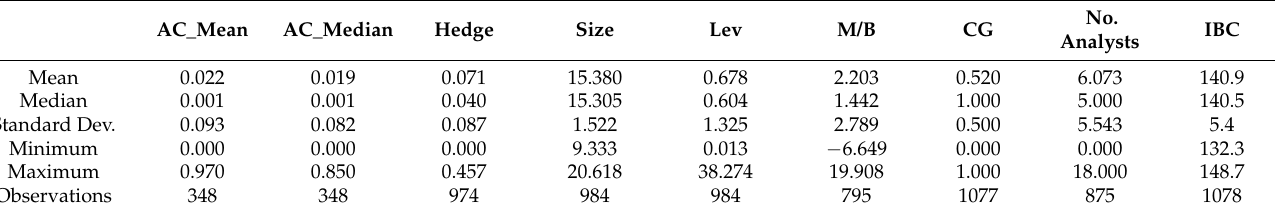
Table 1. Descriptive statistics of the variables of the